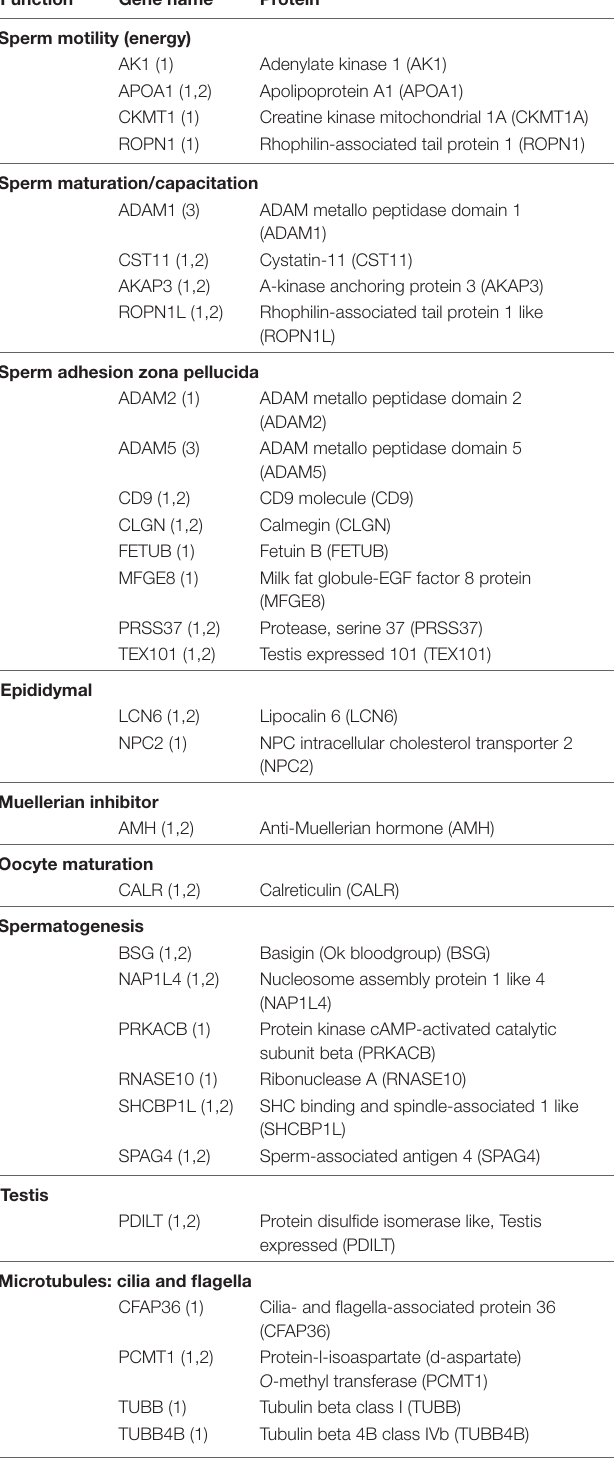
TABLE 3 | Proteins identified in dolphin seminal plasma linked to sperm function